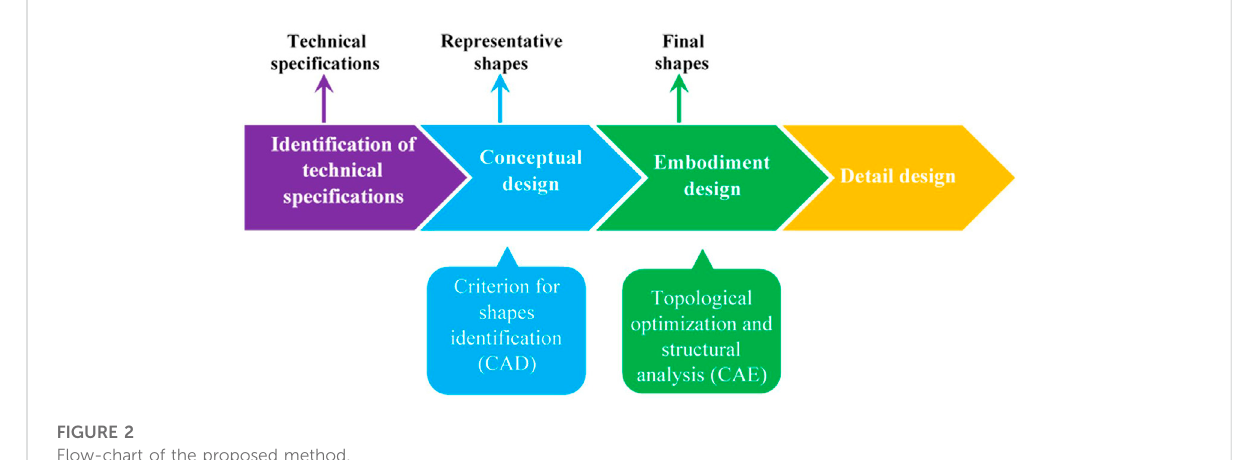
FIGURE 2 Flow-chart of the proposed